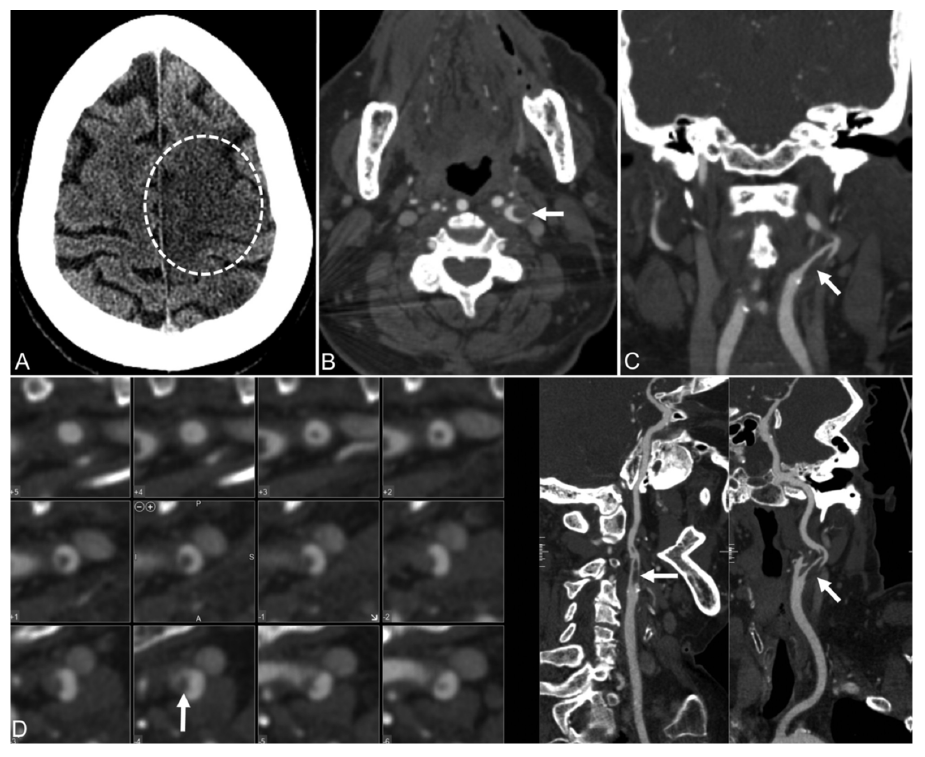
Figure 12. Patient 2. ( A ) 78 ‐ year ‐ old woman with COVID ‐ 19 and an NIHSS score of 25.The CT of the head without comparison shows an evolving ischemic infarct in the left frontal brain paracentral cortex (dotted circle) and a smaller infarct in the left parietal cortex. ( B – D ), Axial, coronal, and curved reimaged images from CT angiography of the head and neck show an irregular plaque at the left internal carotid artery bifurcation and a capillary filling defect (arrow) extending superiorly in the left internal carotid artery, which matches the ruptured plaque with clot formation [144]. Table 4. Effect of COVID ‐ 19 on carotid vascular damage.